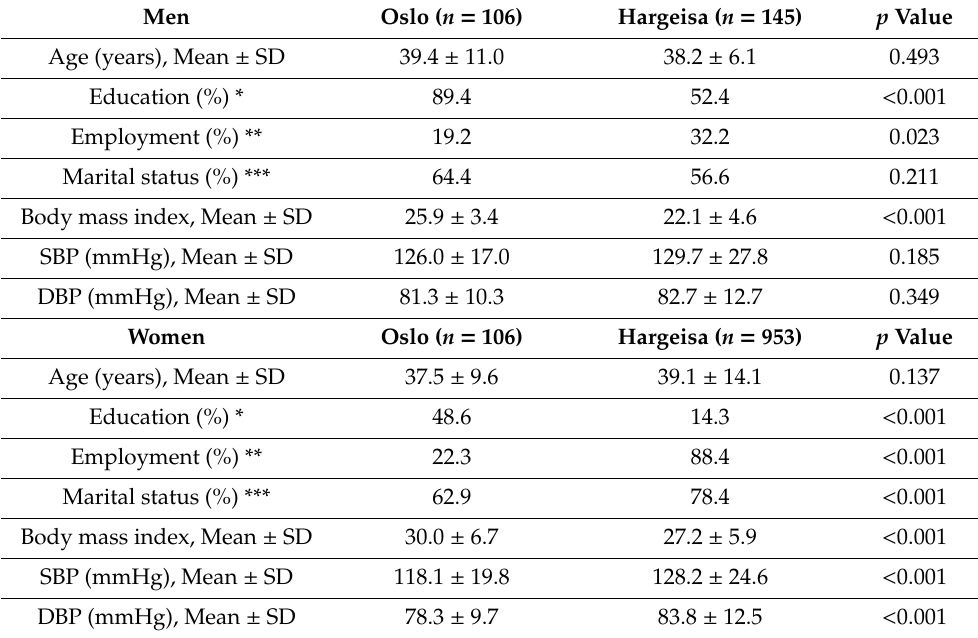
Table 1. Characteristics of the study population in Oslo and Hargeisa (unadjusted). Men